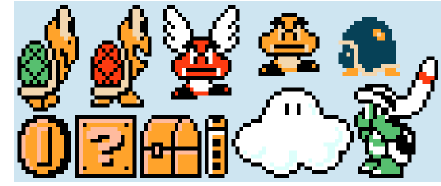
Fig. 2. Sprites with different sizes. Source: Super Mario Bros 3 ©